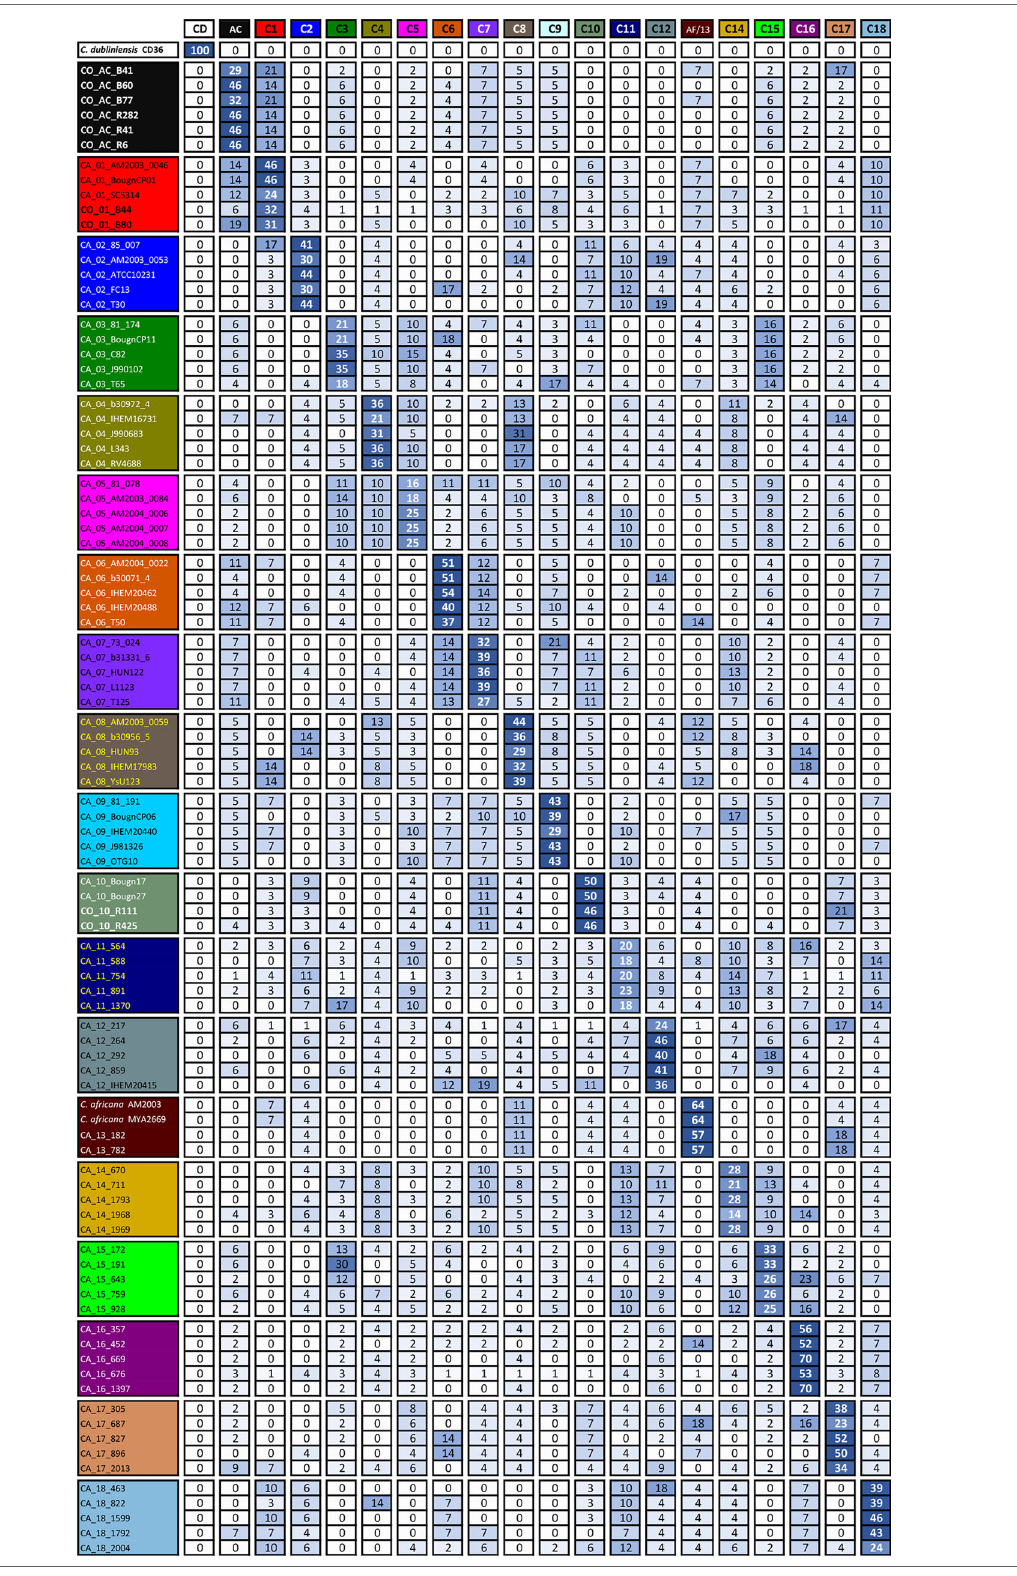
TABLE 2 | Isolates ’ clade